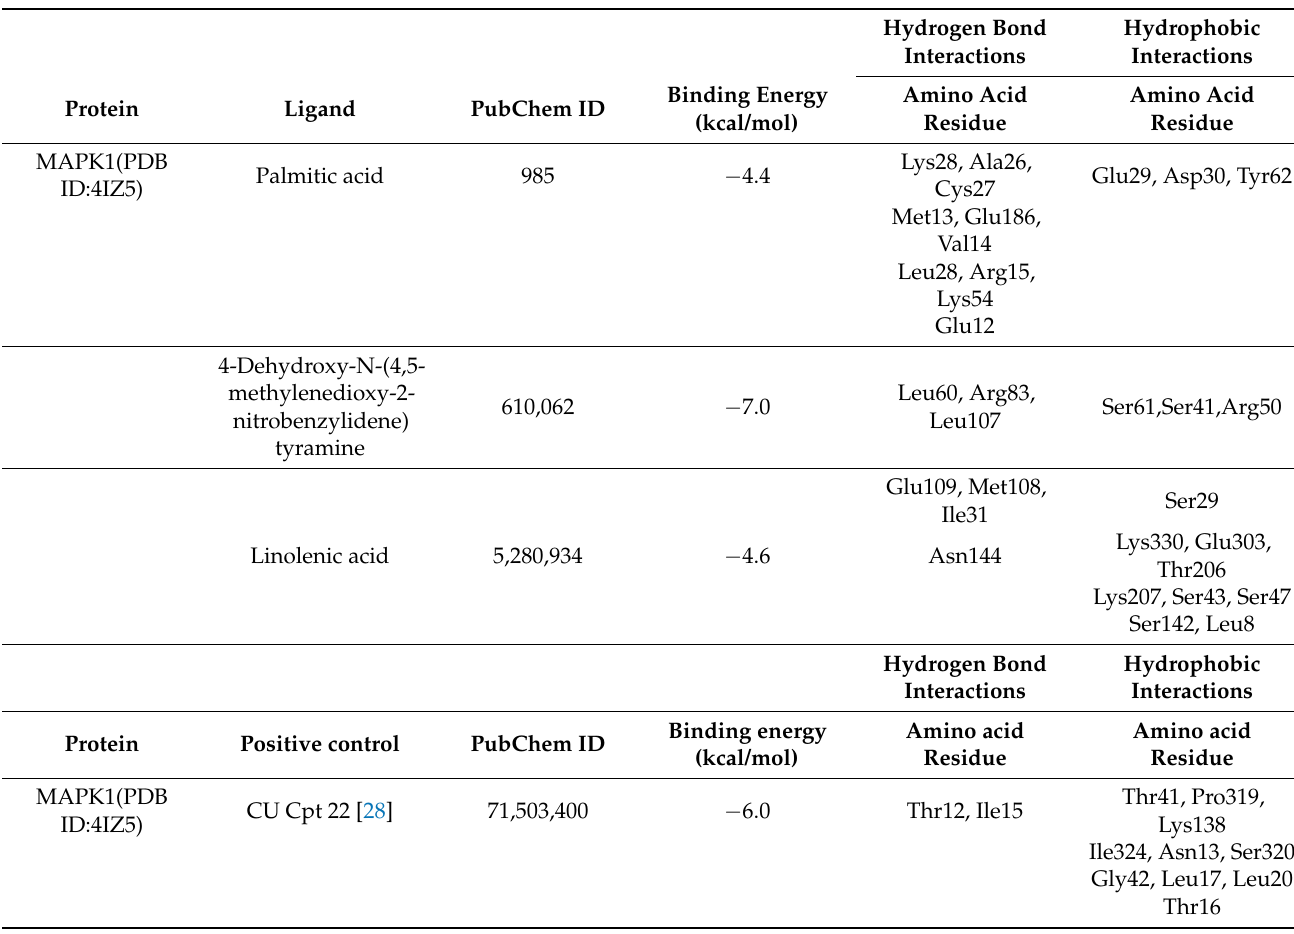
Table 6. Binding energy of potential compounds and a positive control on MAPK1 (PDB ID: